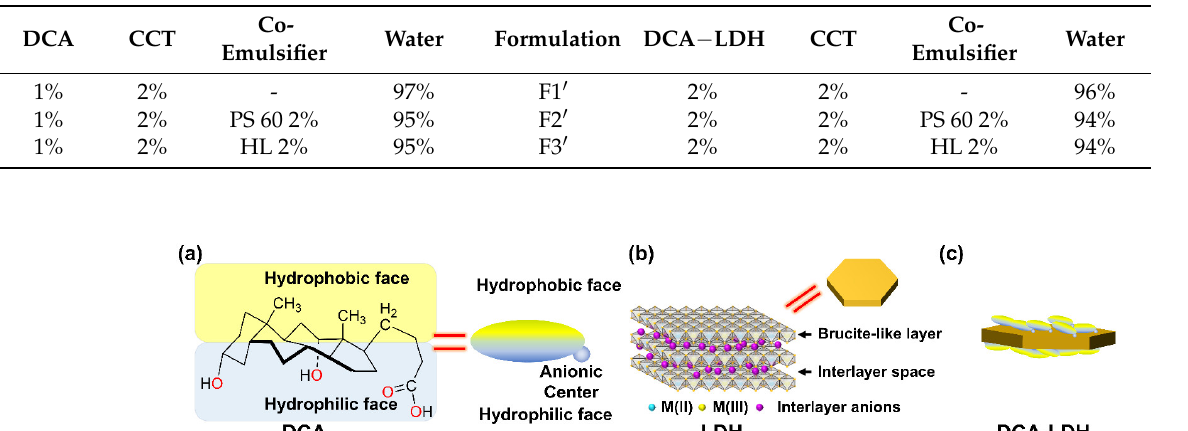
Table 1. Content (in % wt/wt) of DCA or DCA − LDH; CCT; and co-emulsifier in each formulation.